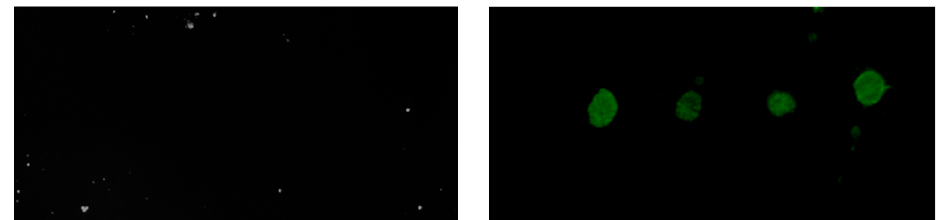
Figure 9. Fluorescence microarray measurements for two TEVS silanized chips where fluorophore labelled haBSA (haBSA*) has been deposited. The chip in the left has not been irradiated with UV light, so the lack of fluorescence indicates that the haBSA* has not been attached to the surface. The chip in the right has been irradiated with UV light after the deposition of the haBSA*, so the presence of fluorescence indicates the successful immobilization due to the thiol–ene coupling (TEC) reaction.